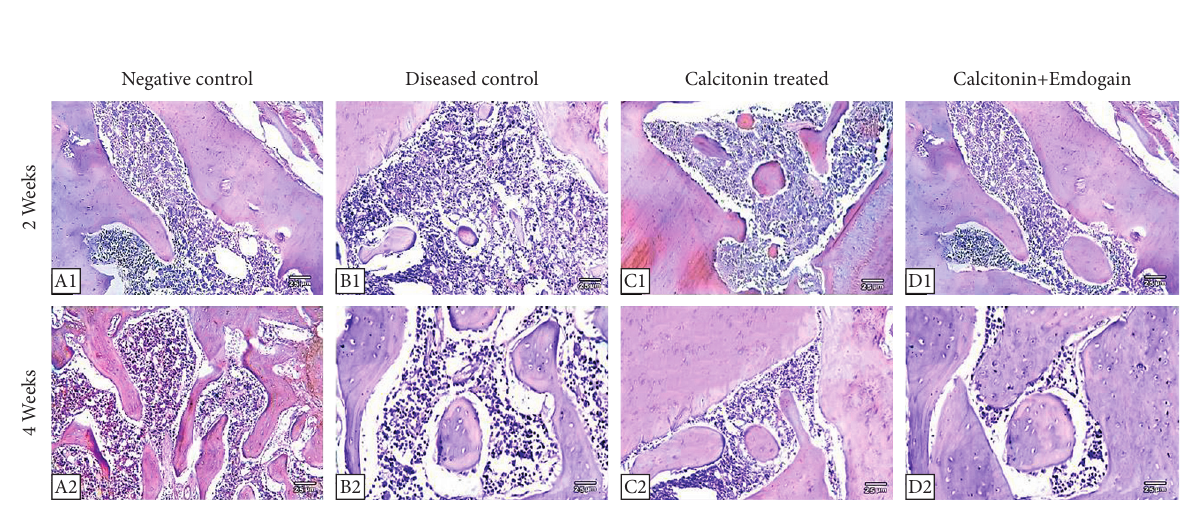
Figure 3: Immunohistochemical stain showed a reduced expression of NF- β in the negative control, calcitonin, and calcitonin+emdogain groups and increased expression of NF- β in the positive control group ( × 100, Table 3: Mean ± SD for the percentage area of NF- κ B at two examination periods.